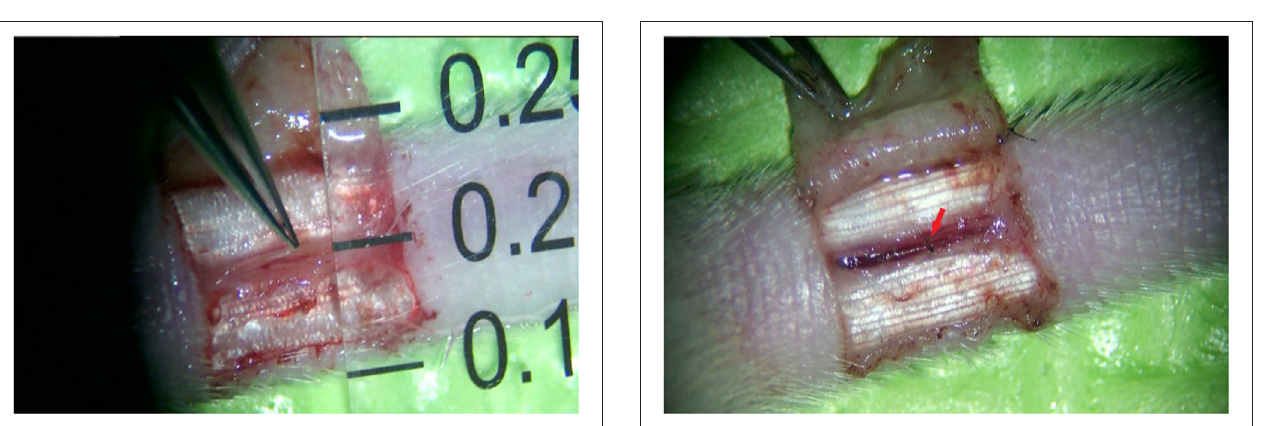
practice microsurgery. Materials like chicken wings and legs